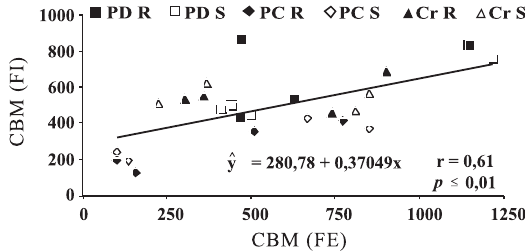
Figura 2. Correlação e coeficiente lineares entre o carbono da biomassa microbiana (CBM) determinados pelos métodos de fumigação– incubação (FI) e fumigação–extração (FE), em um ensaio conduzido em um Latossolo Vermelho distroférrico de Londrina, PR, sob diferentes manejos de solo e das